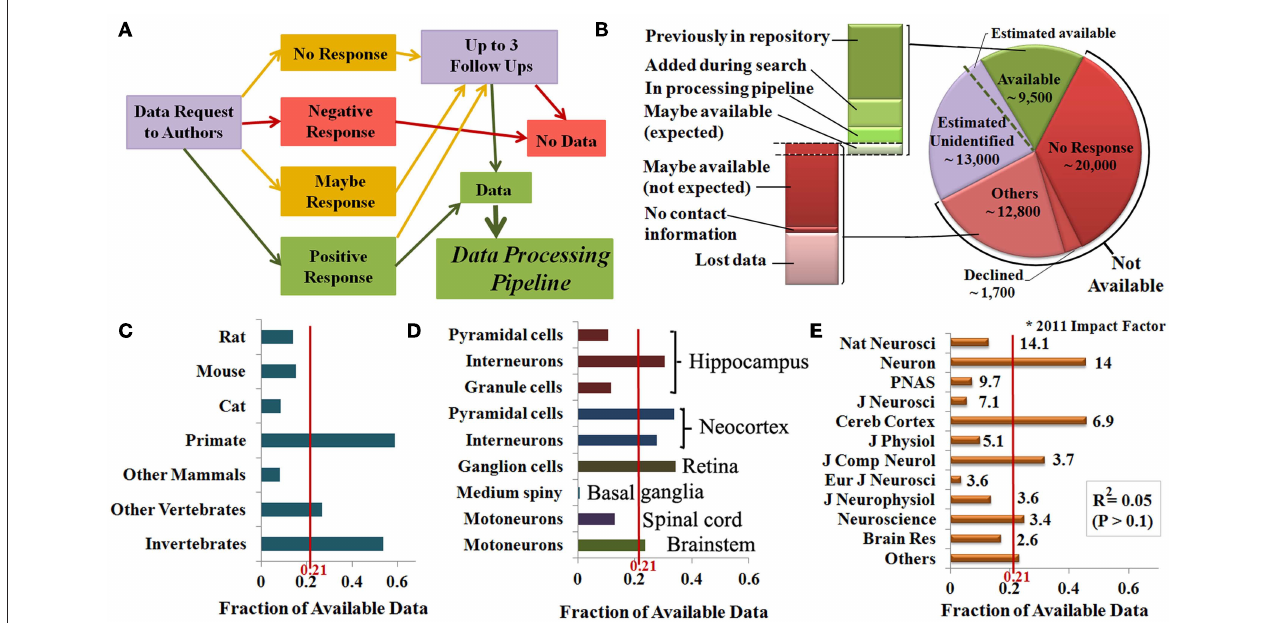
likely remain unidentified (lavender), a small proportion of which could be shared if identified (“Estimated available”). (C–e) The ratio between available data and the total number of identified reconstructions indicates the fraction of available data by species (C) , brain region and cell type (D) , and publication venue (e)